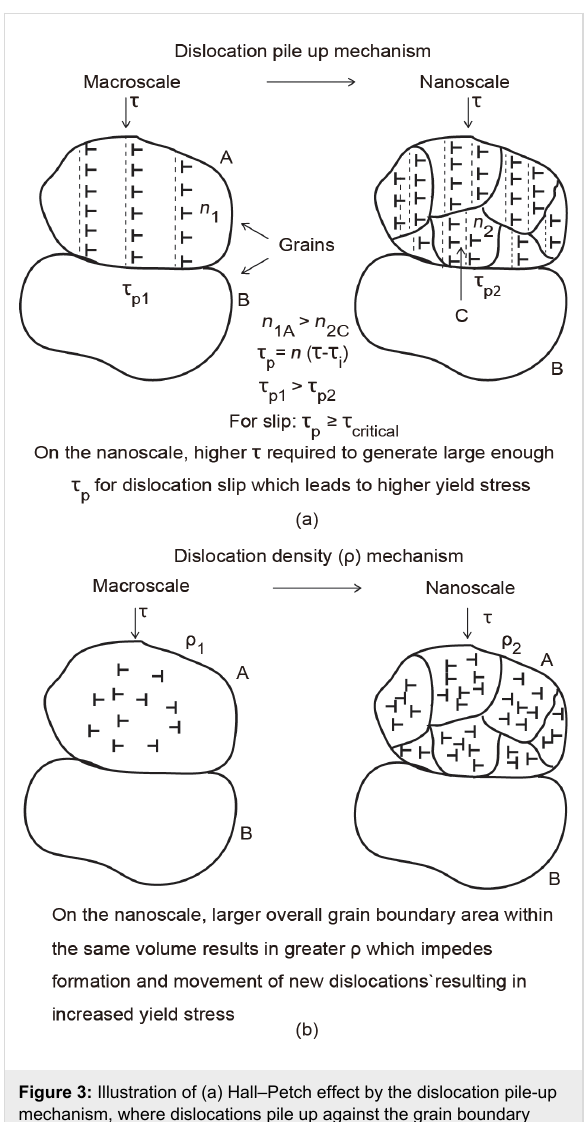
Figure 3: Illustration of (a) Hall–Petch effect by the dislocation pile-up mechanism, where dislocations pile up against the grain boundary under an applied stress τ . The stress at the boundary τ p (pile up stress) which is a function of τ and τ i (internal stress) of the disloca- tions is larger for a bigger grain size (A) on the macroscale due to the larger number of dislocations compared to that for a smaller grain size (C) on the nanoscale. The number of dislocations ( n ) within the grain on the nanoscale is smaller compared to the macroscale, requiring a larger τ to create a pile up stress ( τ critical ) high enough for dislocation slip and plastic deformation which results in a higher yield stress. (b) Dislocation density mechanism where there is a larger overall grain boundary area as grains become smaller within the same volume, resulting in a greater density of dislocations which impede the forma- tion and motion of new dislocations to accommodate strain gradients and results in higher yield stress.